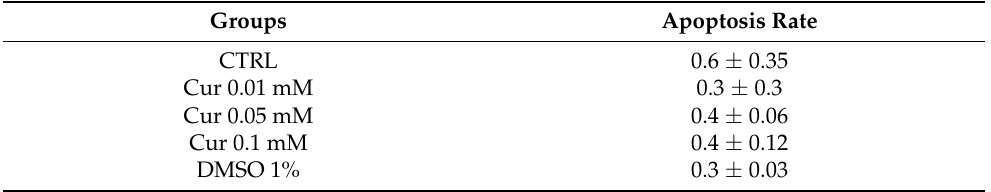
Figure 2. Profiles of apoptosis levels in ARPE-19 cells treated with curcumin (0.01 mM, 0.05 mM, and 0.1 mM) and DMSO 1% obtained by flow cytometry. Green peaks represent cell distribution. The representative profiles of all the vehicles are reported in the Figure S2. Table 1. In the table is reported the mean ± SE of the apoptosis rate in ARPE-19 cells treated with Cur (0.01 mM, 0.05 mM and 0.1 mM) and DMSO 1%. Values represents the percentage of apoptosis for each experimental group. The apoptosis rate of all the vehicles groups is reported in the Supplementary Table S1.